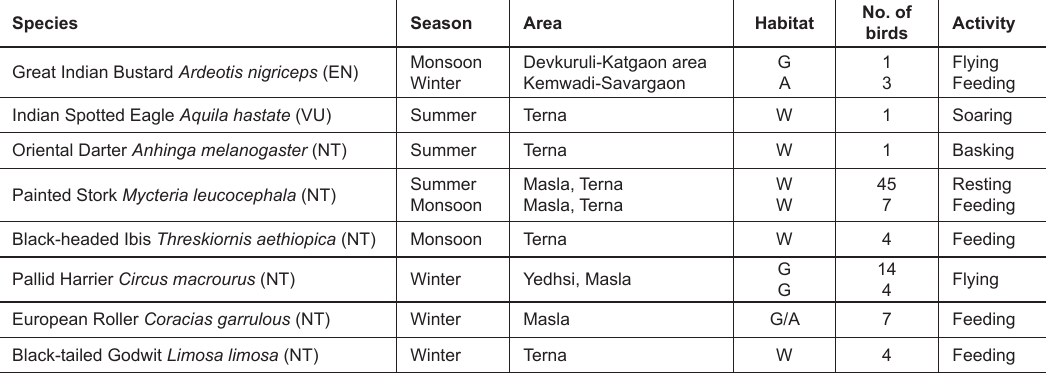
EN - Endangered; NT - Near Threatened; VU - Vulnerable; A - Agriculture; G - Grassland; W -